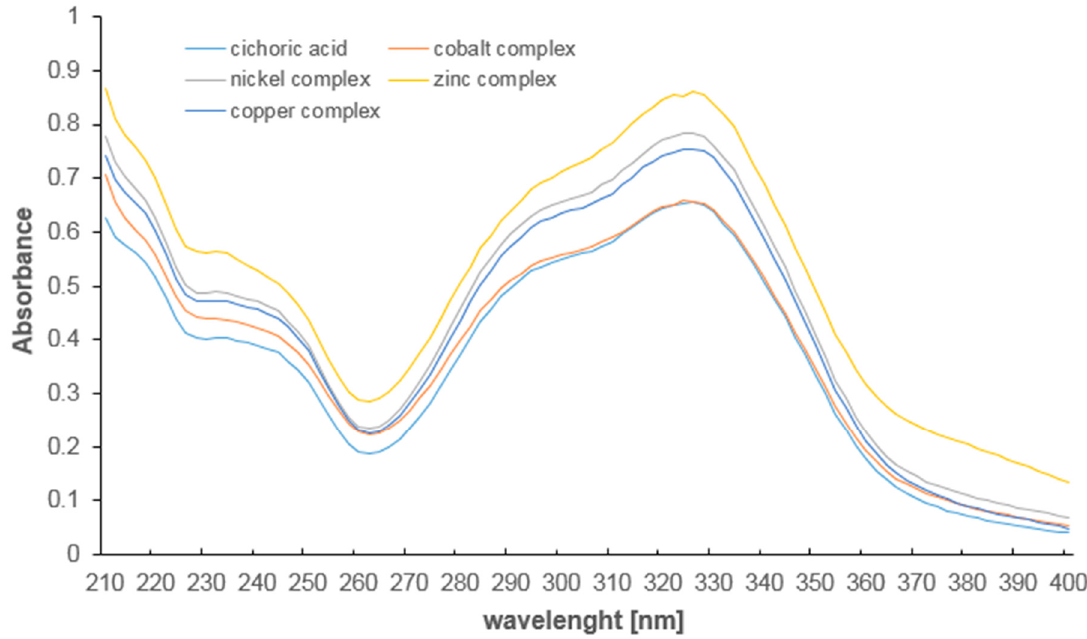
Table 4. The absorbance maximum in the UV spectra of cichoric acid and its metal complexes.